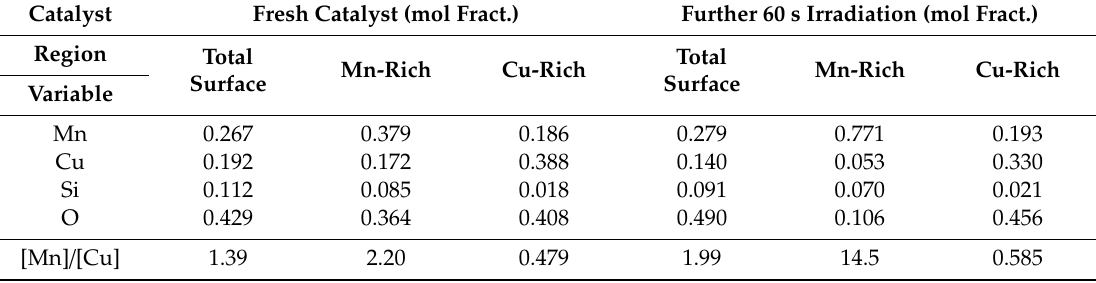
Table 13. Mn / Cu / Si = 1.5 / 0.5 / 1 catalyst composition at Mn-rich and Cu-rich regions showing the e ff ect of co-catalyst and extra microwave irradiation.